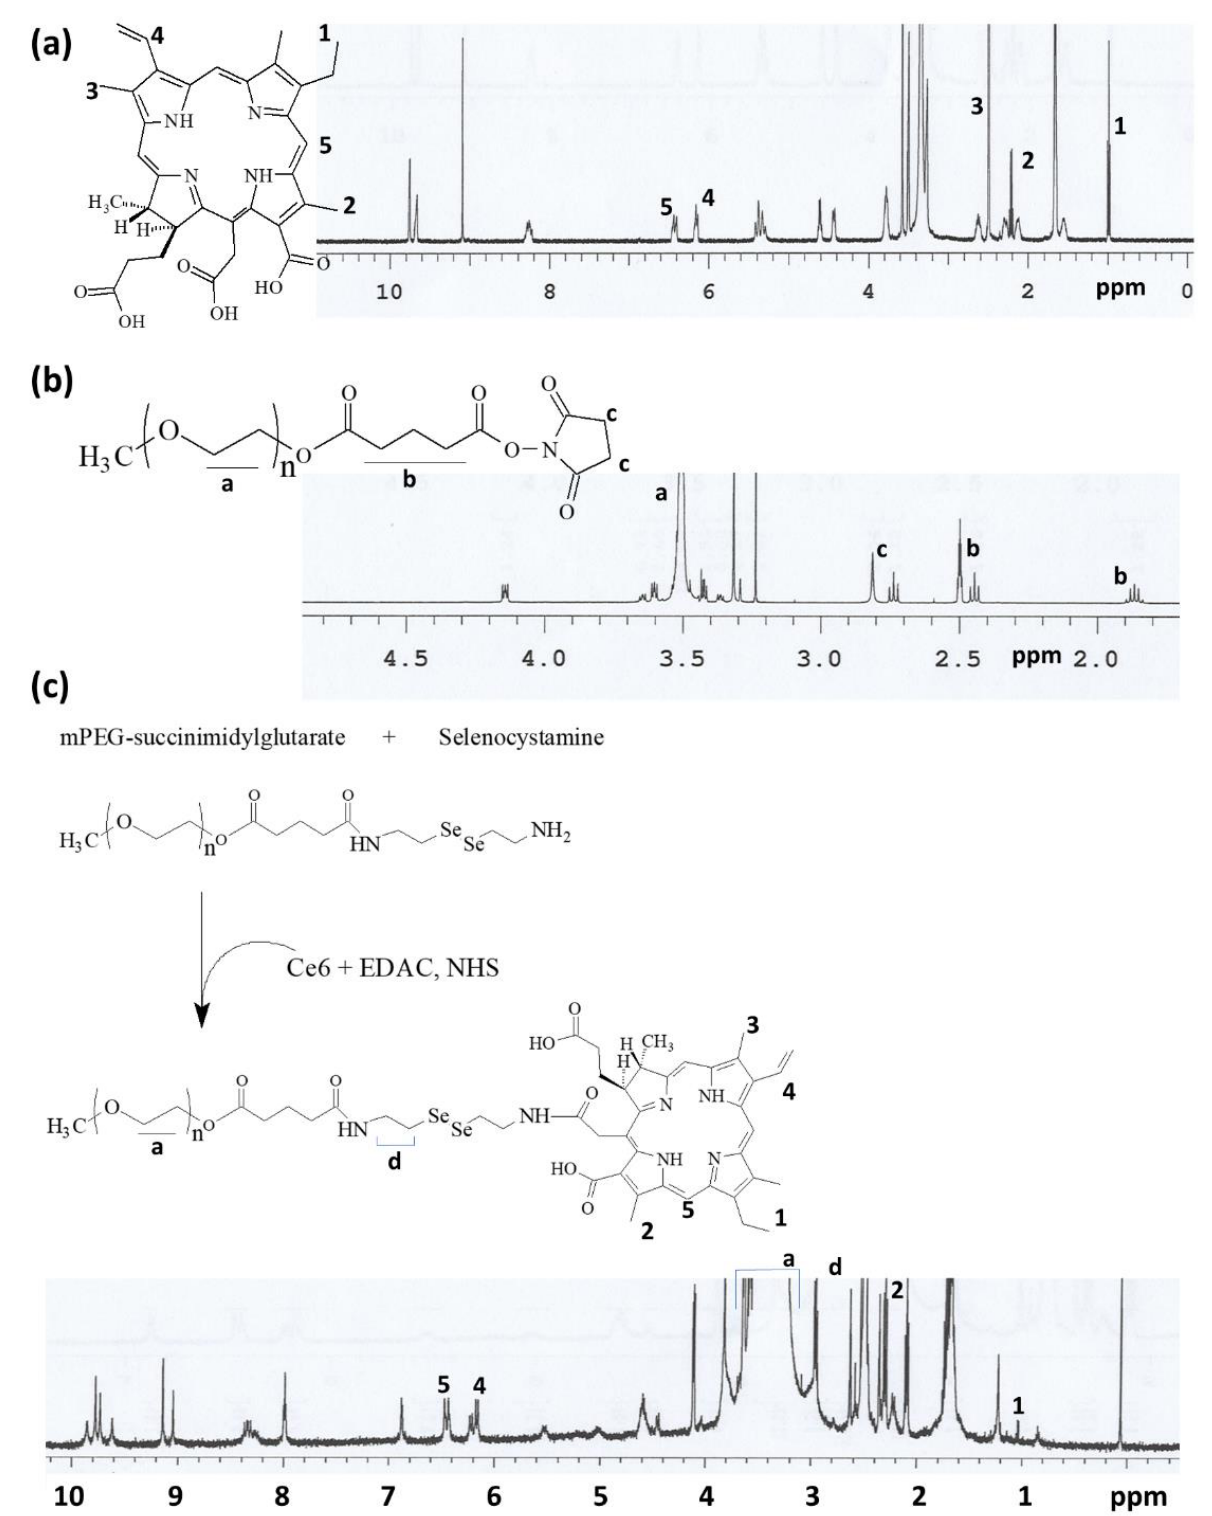
Figure 1. Chemical structure and 1 H NMR spectra of ( a ) Ce6; ( b ) mPEG-NHS. ( c ) Synthesis scheme and 1 H NMR spectra of mPEGseseCe6 conjugates.